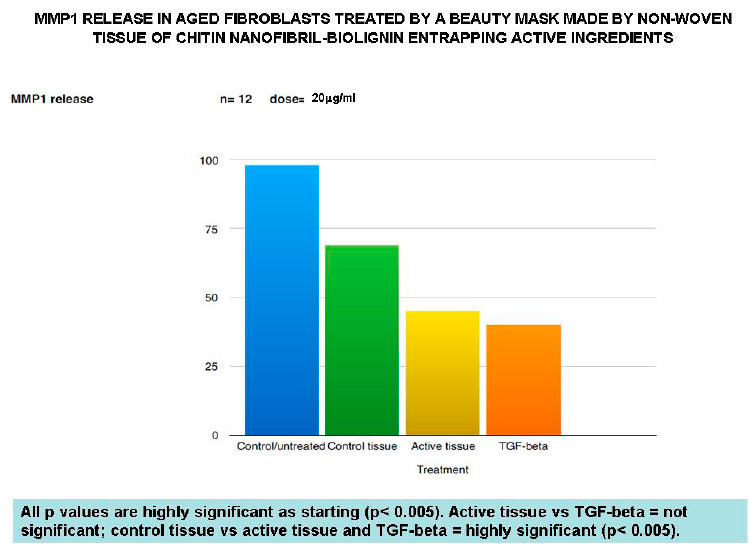
Figure 5. Anti-aging effectiveness of the in mask verified by the reduced release of MMP-1.